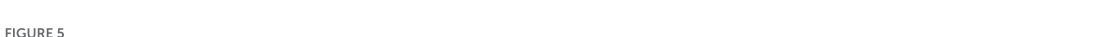
FIGURE5 Expression level of STEAP2 in different tumors and survival prognosis. (A) The expression status of the STEAP2 gene in different cancers or specific cancer subtypes was analyzed through TIMER2. * P < 0.05; ** P < 0.01; *** P < 0.001. (B) Expression level of STEAP2 total protein in normal tissue and primary tissue of breast cancer, liver cancer, lung cancer, PAAD, UCEC, GBM, and ovarian cancer according to the CPTAC dataset. * P < 0.05; *** P < 0.001. (C,D) Overall survival and disease-free survival analyses of different tumors based on STEAP2 gene expression in TCGA. The survival map and Kaplan–Meier curves show positive results.